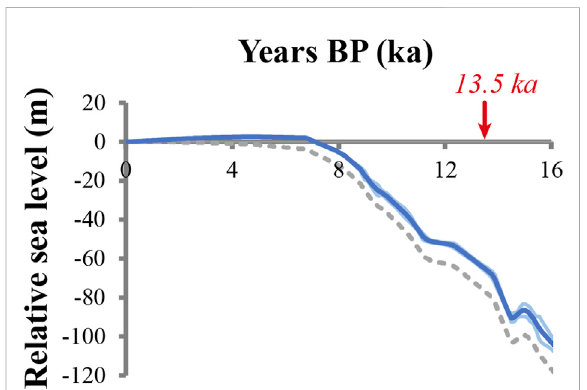
FIGURE 10 Model of late Quaternary sea level rise in Oomurodashi area. ModeladaptsglobalsealevelcurveofLambecketal.(2014)forthe average uplift of 0.86 mm/yr of the Tokai region resulting from ongoing collision of Izu-Bonin arc with mainland Japan (Okuno et al., 2014); sea level curve is shown in blue. Light blue derives from error on original curve. Unadjusted (Lambeck et al., 2014) model shown in grey for comparison. 13.5 ka age of Od-1 tephra is indicated by